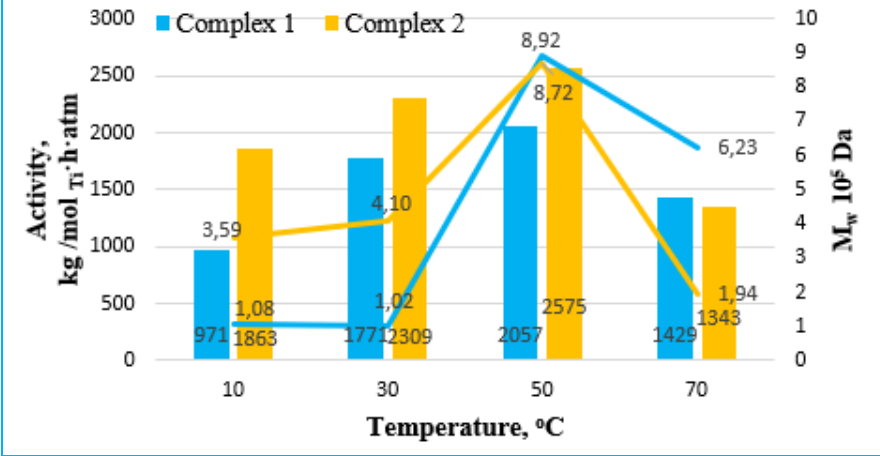
Figure 5. Influence of polymerization temperature on productivity of catalytic systems ethylene/1- octene copolymerization on M W of resulting copolymers. Table 3. Ethylene/octene-1 copolymerization a .